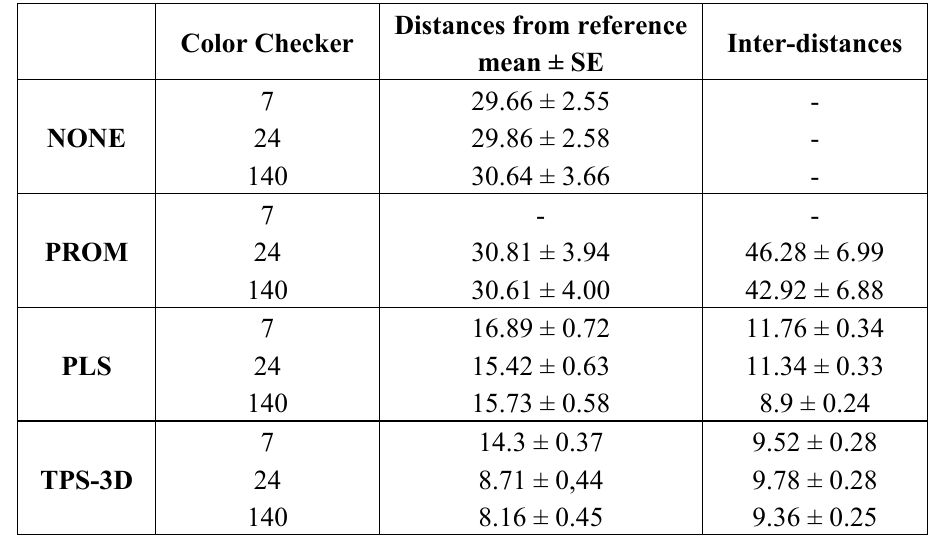
Table 4. Results of the Calibration Experiments (ColorCheckers): values refer to the performance of the calibration methods taking into account the ColorChecker (see Table 1 for